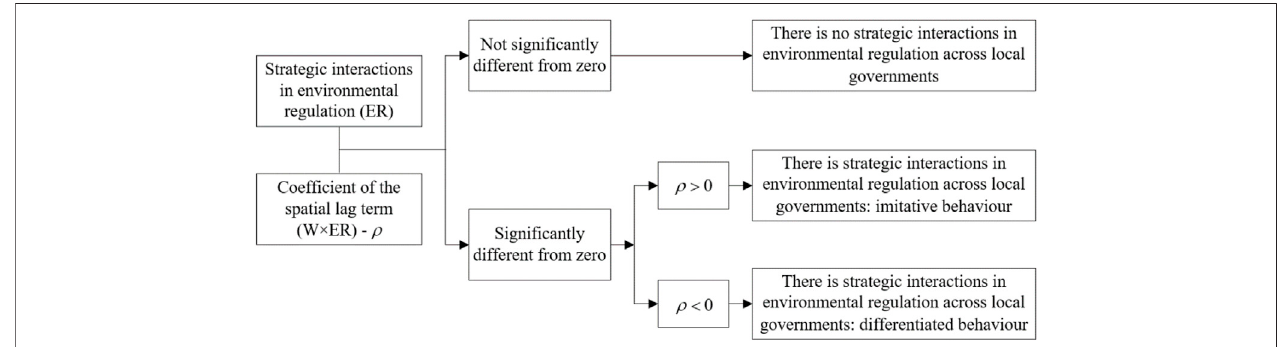
FIGURE 2 | The relationship between the coef fi cient of the spatial lag term and strategic interactions in environmental regulation.